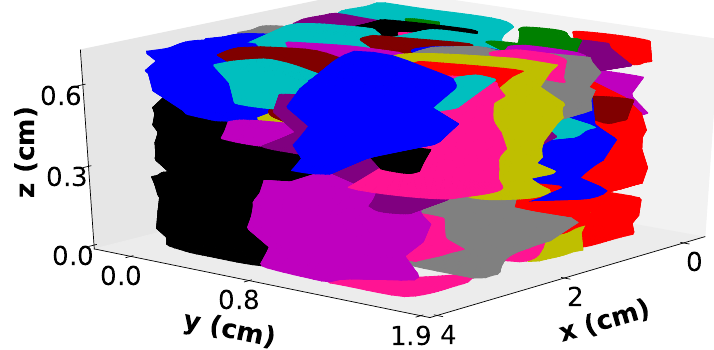
Figure 7. 3D reconstructed envelope of the dendritic microstructure. Each color in the web version accounts for one